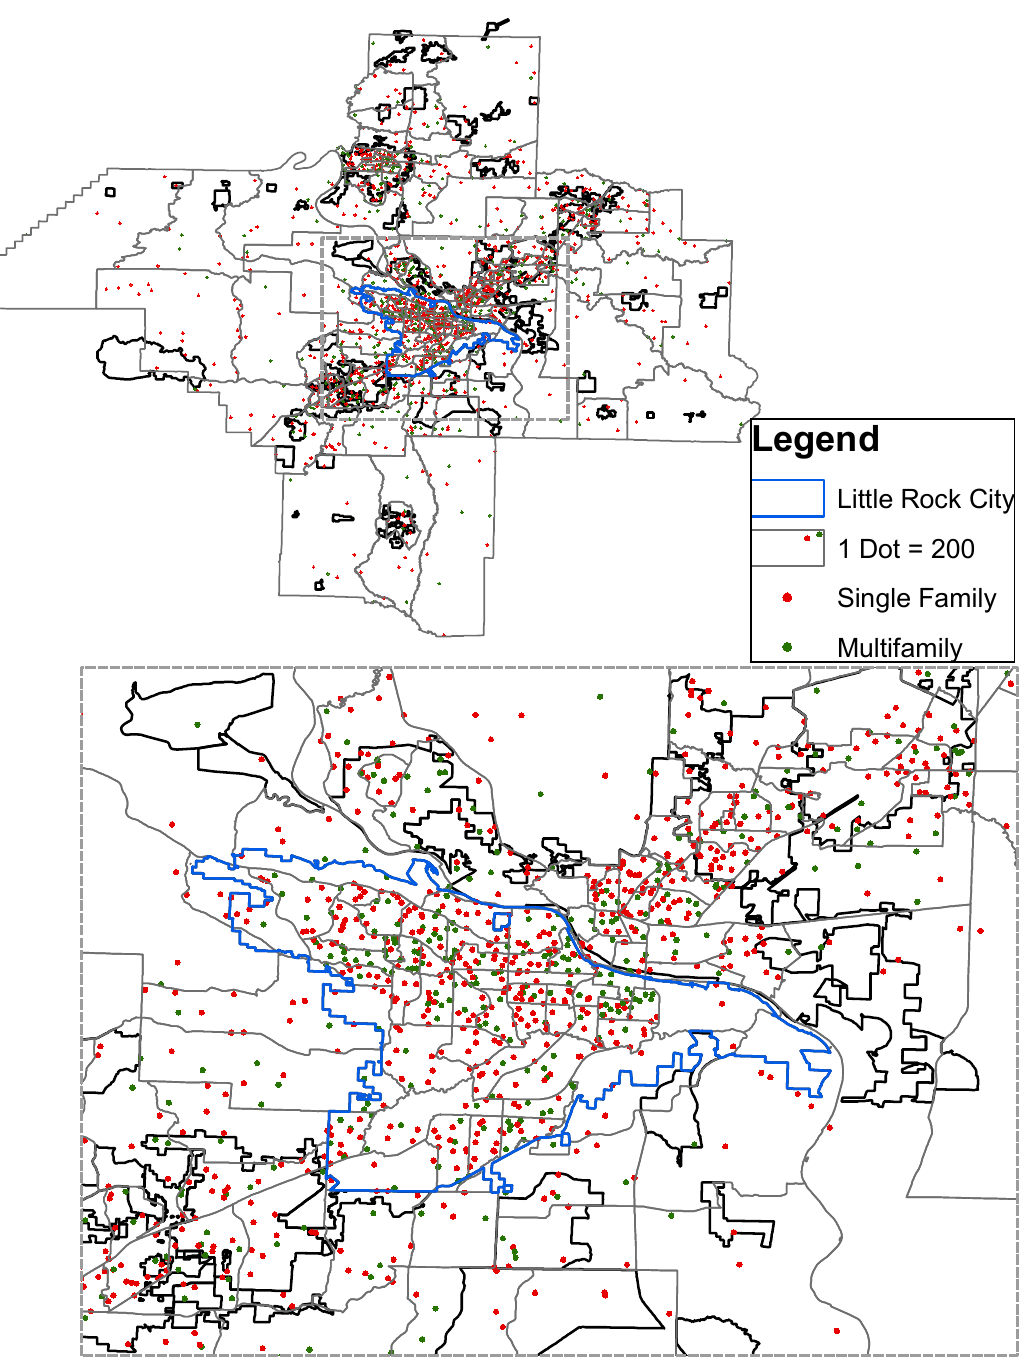
Figure 3: Single-family and multifamily housing units in the Little Rock–North Little Rock metropolitan